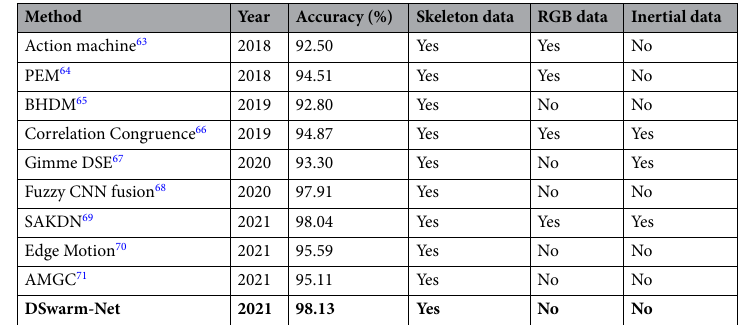
Table 6. Comparison of our DSwarm-Net model with some recent models on the UTD-MHAD dataset by cross-subject analysis.